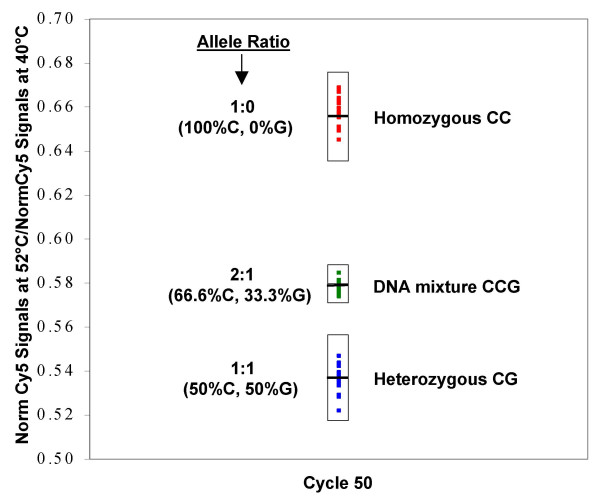
Identification of imbalance allele ratios using the Two-Temperature LATE-PCR endpoint assay. Replicate samples (n = 16) containing 1000 genome-equivalents of heterozygous TSD G269 DNA (1:1 C to G allele ratio) or a DNA mixture containing a 2:1 ratio of the same two alleles (see Materials and Methods) were analyzed by Two-Temperature LATE-PCR using primer/probe pairs for the TSD G269 polymorphism. Fluorescence signals were collected prior to LATE-PCR amplification at 70°C and after LATE-PCR amplification at 52°C and 40°C to calculate the normalized endpoint fluorescence ratios (see Materials and Methods). Blue dots, heterozygous (1:1 C-toG allele ratio) fluorescence ratios; green dots, DNA mixture (2:1 C-to-G allele ratio). The black boxes represent the boundary of three-standard deviations on either side of the mean of replicate control samples signals for each genotype and statistically define the 99.7% confidence interval for identification of each genotype.